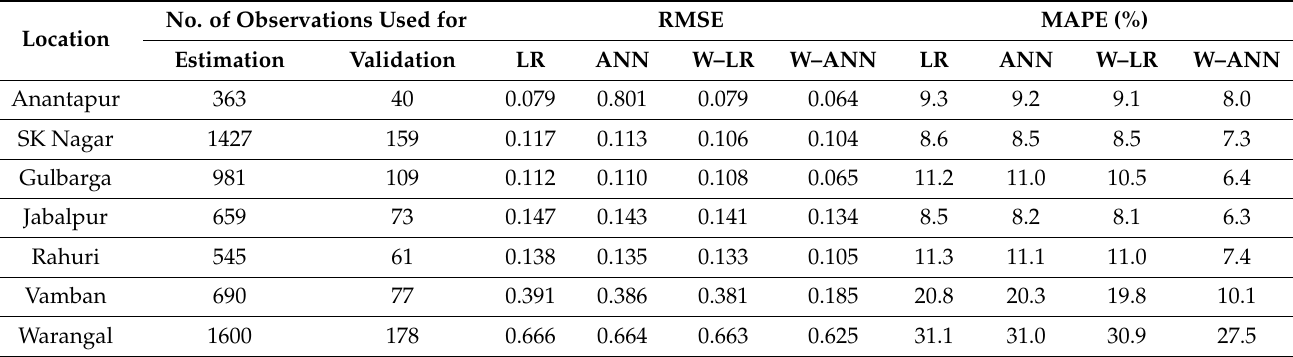
Table 8. RMSE values in relation to Linear Regression (LR), Wavelet–Linear Regression (W–LR) and Wavelet–ANN (W–ANN) models predicting of spiders.